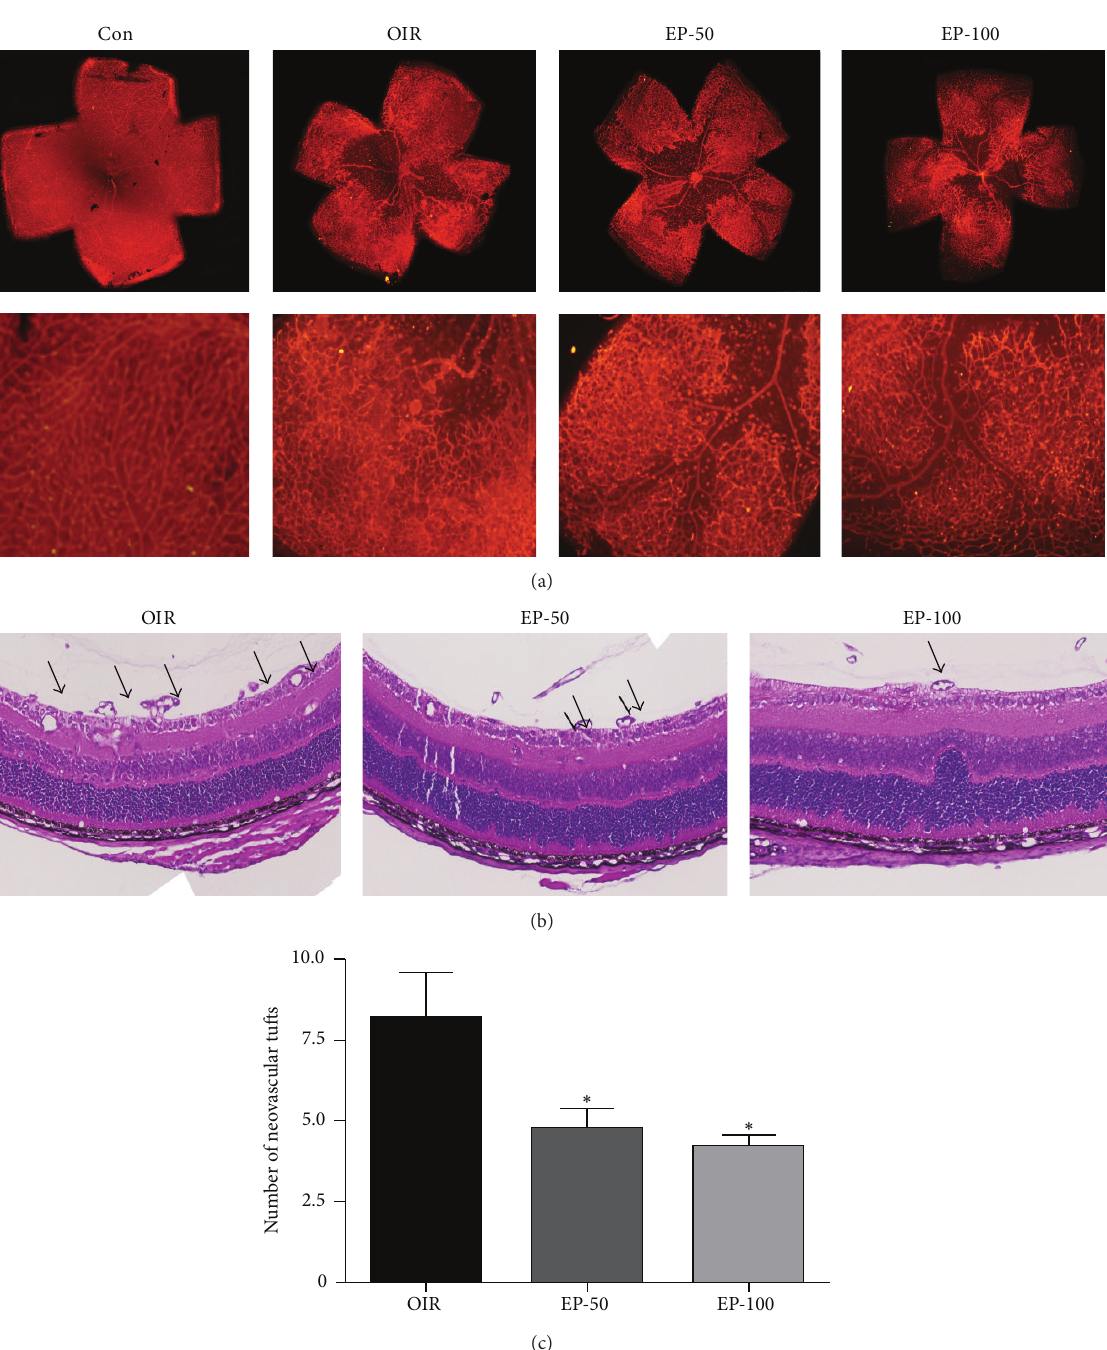
Figure 2: The effect of EP on retinal neovascular tufts in OIR mice. (a) The retinal neovascular tufts were determined using isolectin B4 staining. The retinal preparation from P17 control (Con), OIR (OIR), 50mg/kg EP-treated (EP-50), and 100mg/kg EP-treated (EP-100) mice. (b) The arrows indicate neovascular tufts of intravitreous neovascularization. Hematoxylin and eosin-stained cross-section preparations are from P17 OIR (OIR) 50mg/kg EP-treated (EP-50) and 100mg/kg EP-treated (EP-100) mice. (c) Quantitative analyses revealed that EP treatment significantly reduced the retinal neovascular tufts compared with OIR. The data are expressed as the mean ± SE (𝑛 = 4) . ∗ 𝑃 < 0.05 versus the OIR